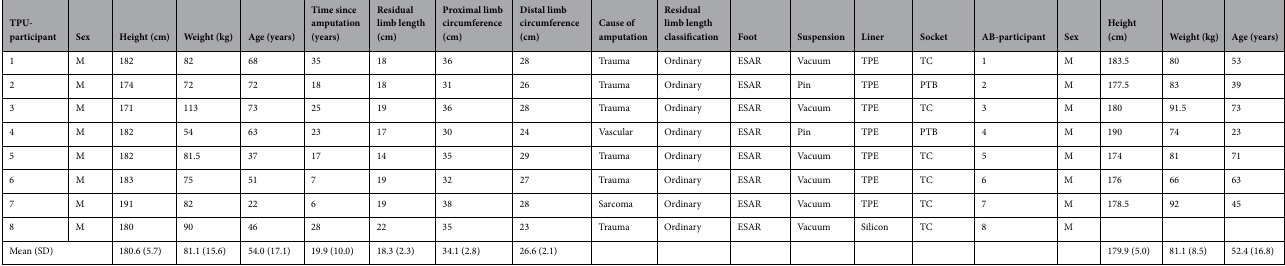
Table 1. Participant characteristics for the two groups (TPU: left; AB: right). Descriptive data for: sex, height (cm), weight (kg), age (years), time since amputation (years), residual limb length (cm), proximal residual limb circumference (cm), distal residual limb circumference (cm), cause of amputation, residual limb length classification (modified from: 28 ), foot (foot classification 29 ), suspension (vacuum—elevated vacuum; pin—pin suspension), Liner (TPE—thermoplastic elastomer, silicon—silicon liner), socket (TC—total contact; PTB— patellar tendon-bearing). Numerical data presented with mean and standard deviation